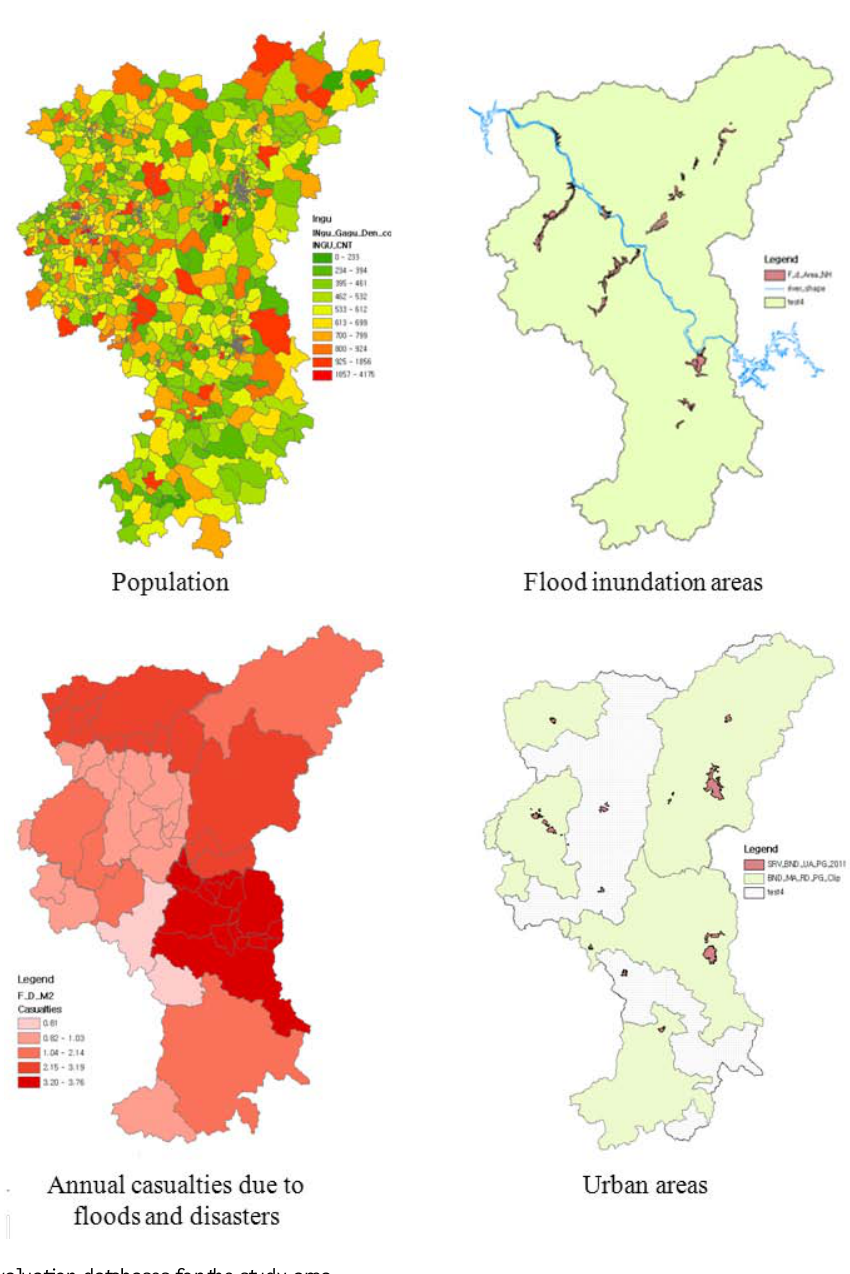
Fig. 6. Examples of evaluation databases for the study